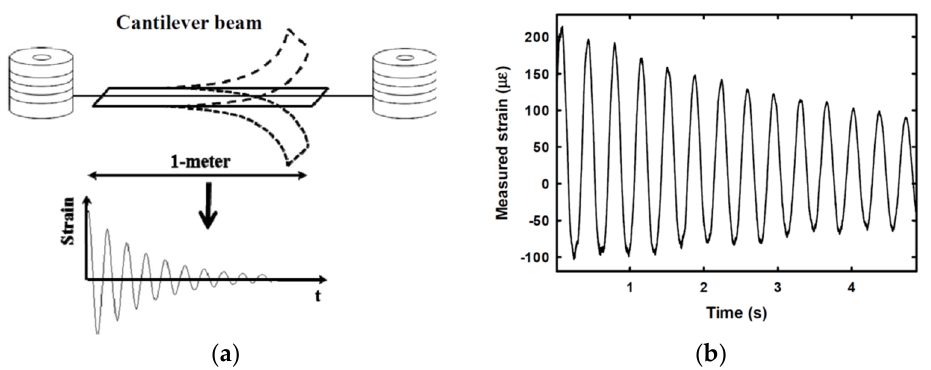
Figure 11. Experimental demonstration of dynamic strain measurement ( b ) over a 1-m cantilever beam subjected to vibration ( a ), carried out using the setup of Figure 10 [47].